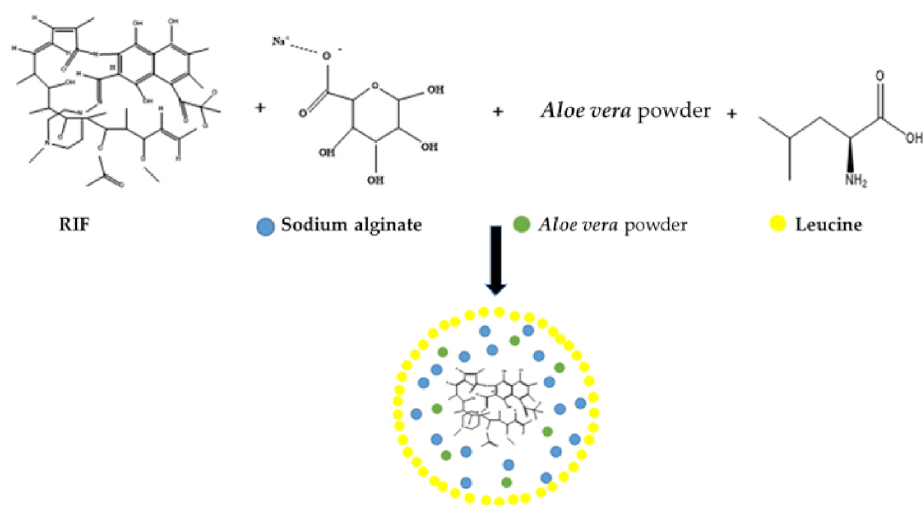
Figure 2. Schematic representation of drug, matrix former, spray drying excipient and spray-dried RIF-loaded microparticles (adapted from